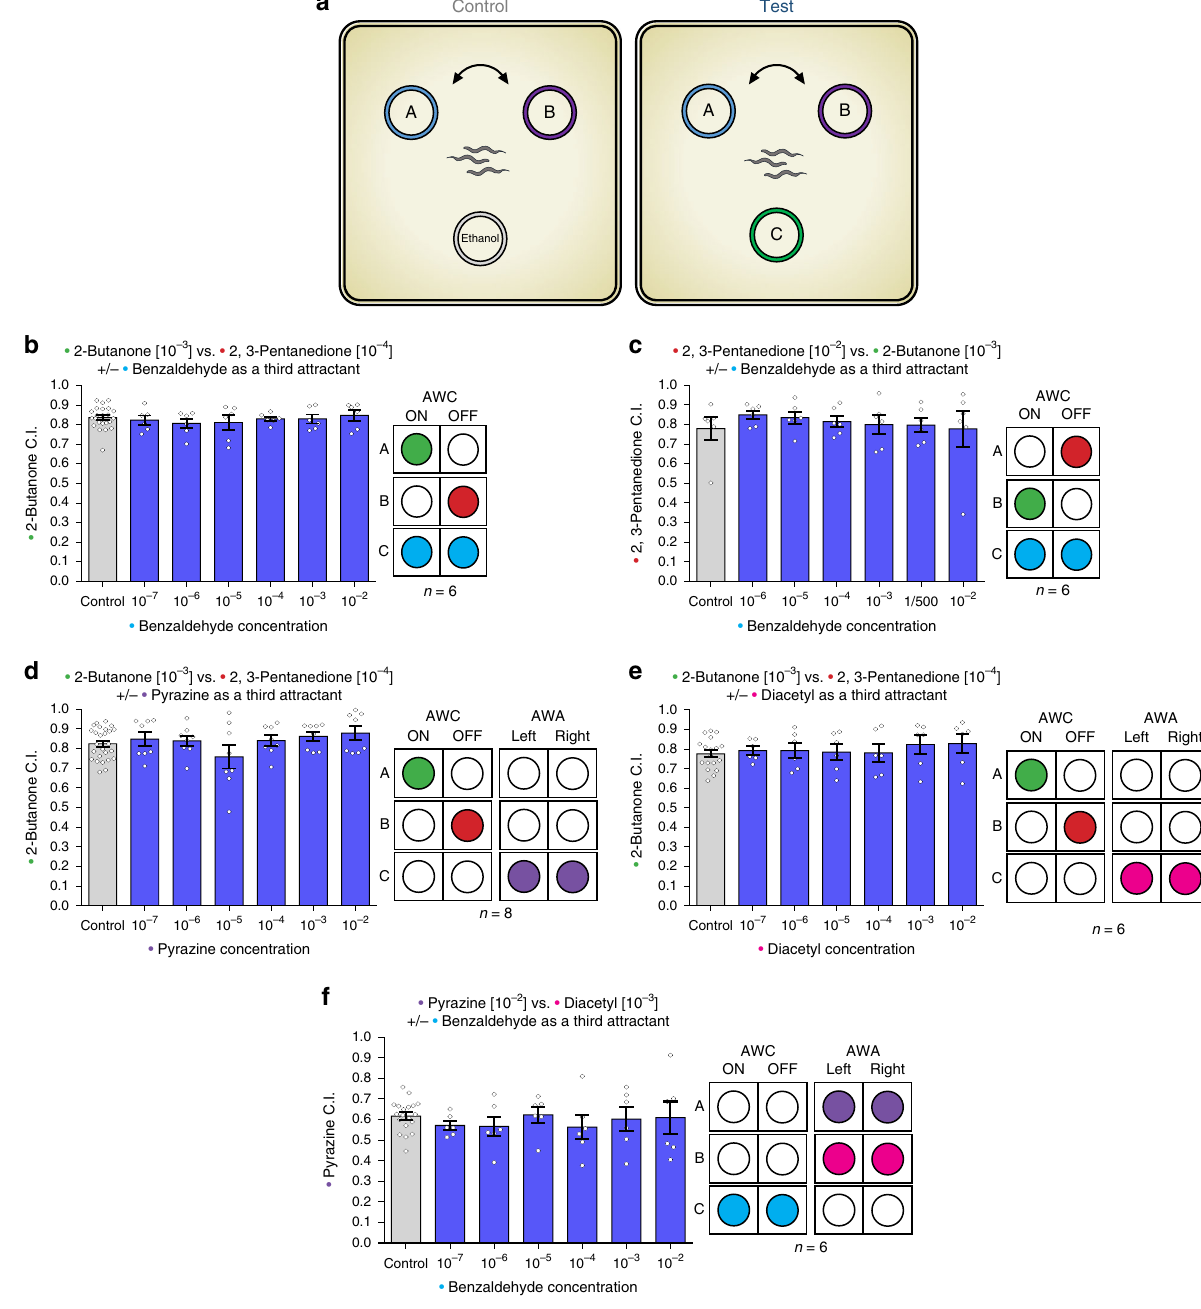
Fig. 1 C. elegans display rational decisions. a A scheme for the Independence of irrelevant alternatives chemotaxis assays. A chemotaxis index (C.I.) (number of worms in A, divided by the number of worms in A and B together) was calculated. Each plate contained ~200 – 400 worms. b The relative preference for 2-butanone over 2,3-pentanedione is unaffected by increasing concentration of benzaldehyde as a third attractant (two-tailed Wilcoxon signed-ranks test; n = 6). c The relative preference for 2,3-pentanedione over 2-butanone is unaffected by increasing concentration of benzaldehyde as a third attractant (two-tailed Wilcoxon signed-ranks test; n = 6). d , e Introducing AWA- sensed odorants as a third attractant, does not in fl uence the relative preference between 2-butanone and 2,3-pentanedione (two-tailed Wilcoxon signed-ranks test; d n = 8, e n = 6). f Benzaldehyde as a third attractant, does not affect the relative preference between the two AWA- sensed odorants pyrazine and diacetyl (two-tailed Wilcoxon signed-ranks test; n = 6). Two-tailed Wilcoxon signed-ranks test. Bars represent the C.I. of odor A. Error bars represent the standard error of the mean underlying the decision process, we tested combinations of odors inconsistencies in decision-making (Fig. 1d – f and Supplementary that are sensed by both AWC and AWA neurons. We started by Fig. 2c – e). All the results presented above demonstrate that the testing “ balanced ” third odors C, in the sense that these odors are worm ’ s decision-making process can be consistent and robust at not sensed preferentially just by the neurons that sense odor A or least when the irrelevant alternative is sensed symmetrically, in a odor B. We found that increasing the circuit complexity through balanced way, by the neurons that sense odor A and the neurons the addition of another pair of neurons does not lead to that sense odor B.